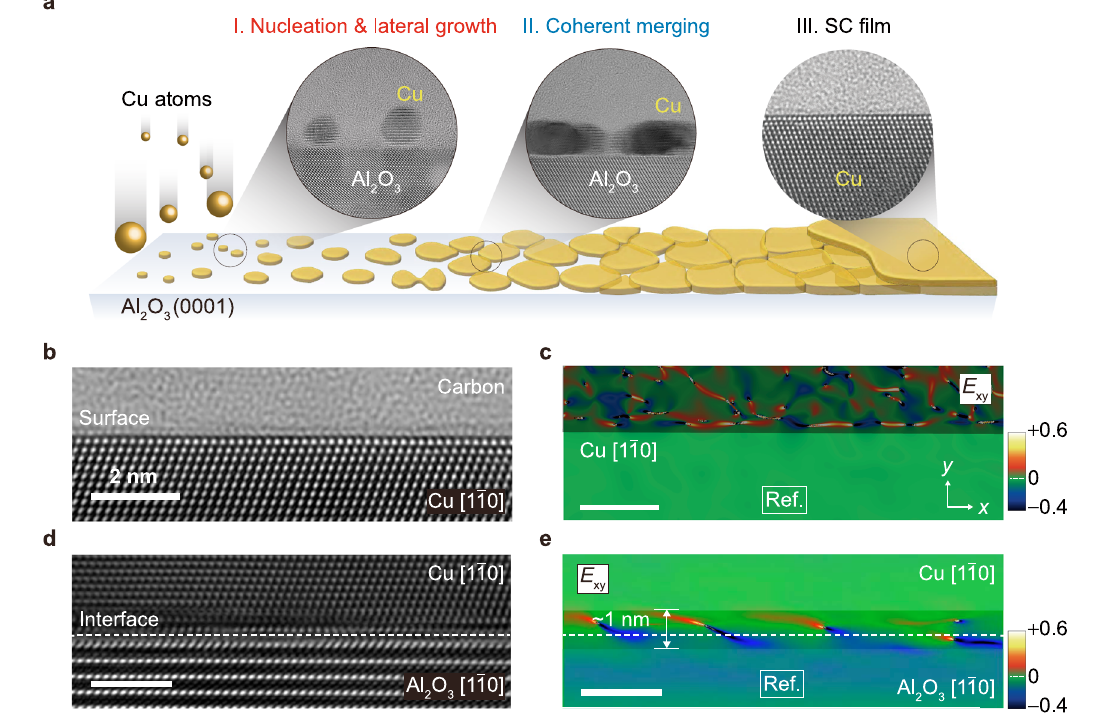
Fig. 1 | Coherent consolidation of nucleations and a mono-atom step-level fl at surface.a Seriesofschematicdiagramsofthestructuralevolutionfromquasi-zero- dimensionalCu(111)nanodropletstoaquasi-two-dimensionalsingle-crystalCu fi lm in three stages: (I) nucleation and lateral growth, (II) coherent coplanar merging and (III) layer-by-layer growth. b , c Cross-sectional high-resolution transmission